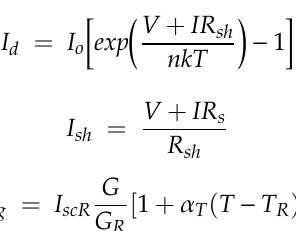
Figure 5. Equivalent Circuit of PV Panel.